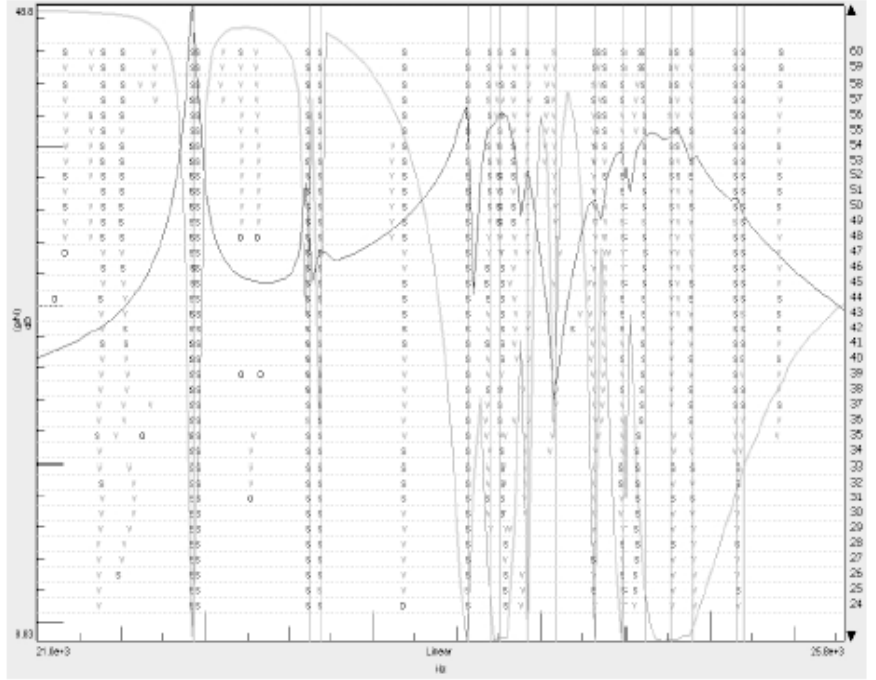
Fig. 8. The stabilization diagram accelerometers based test.